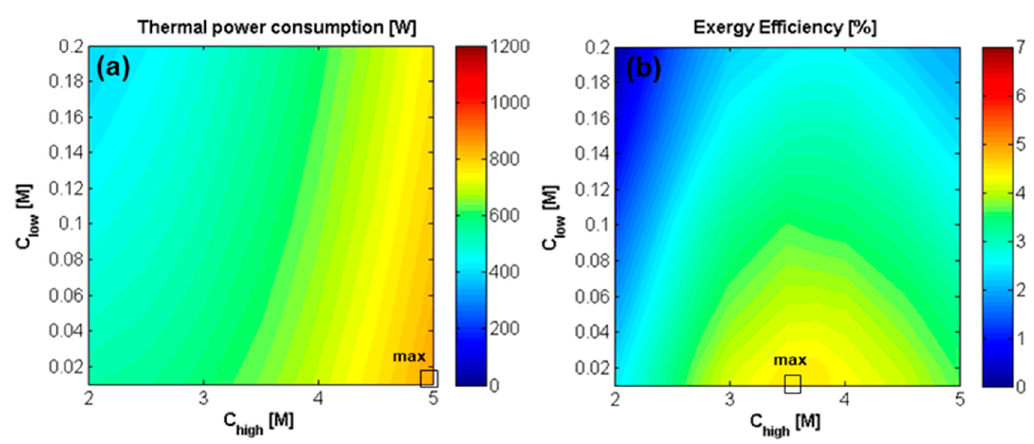
Figure 13. Effect of inlet solutions concentration on ( a ) the thermal power consumption [W] of the MED unit, and on ( b ) exergy efficiency of RED-MED Closed loop. RED stack: 50 cell pairs, membrane area of 0.1 × 0.88 m 2 , counter-current arrangement, v H , in = v L , in = 1 cm/s. MED: T hot = 100 ◦ C, T cold = 20 ◦ C, optimized number and area of the effects.